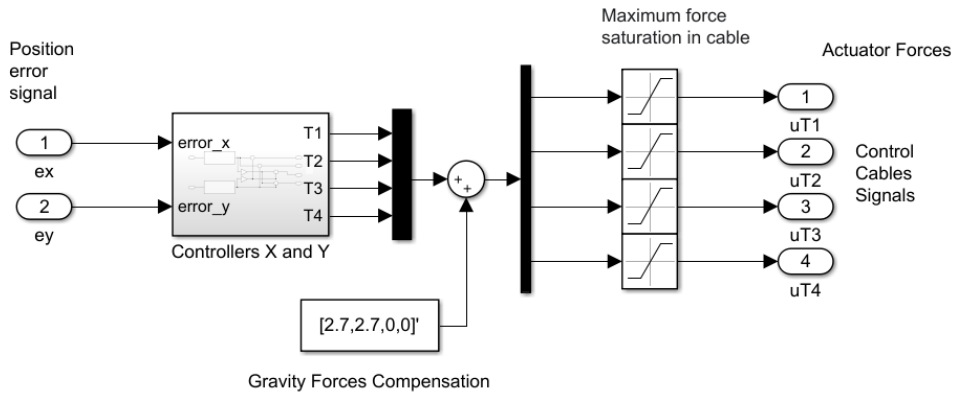
Figure 10. Structure of a decoupled control system for a planar CDPR.